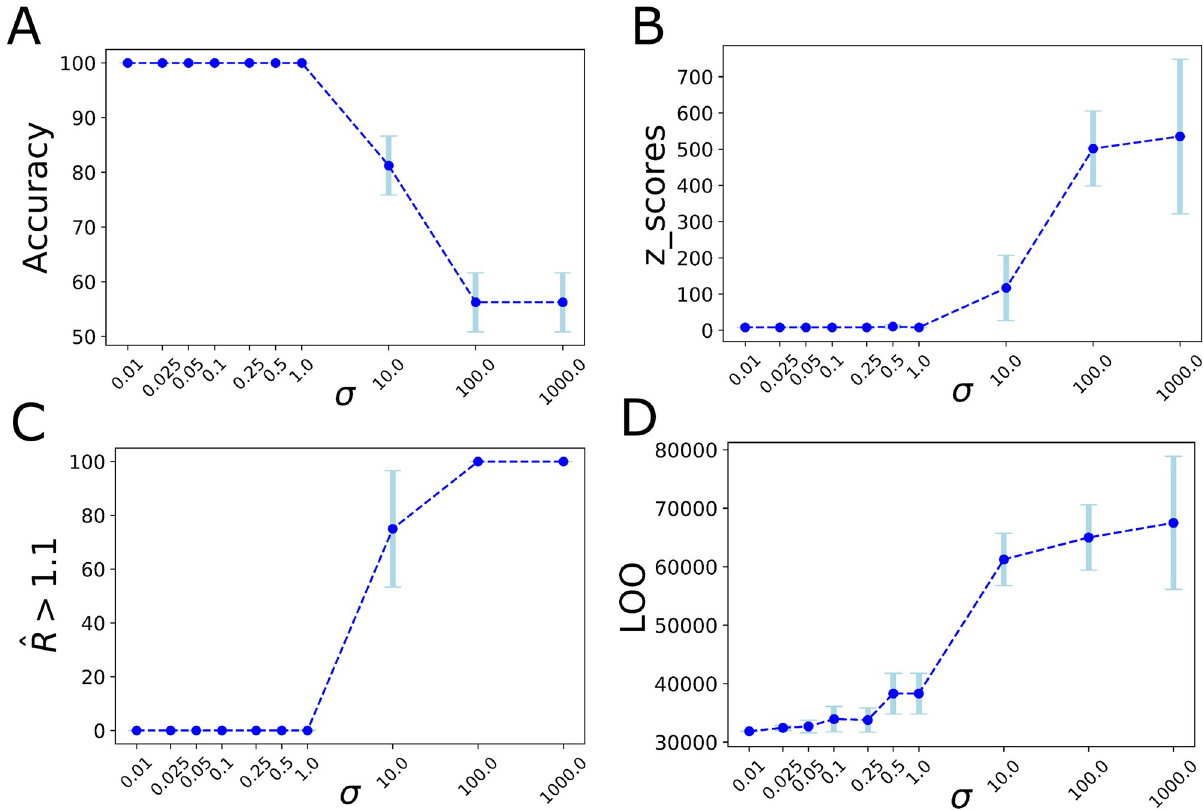
Fig 5. Effect of the prior on the model performance in the epileptogenicity estimation. Here, the prior placed on global coupling parameter K is assumed as a Gaussian distribution N ð m ¼ 1 ; s 2 Þ , where σ represents the uncertainty about the estimation varying from 0.01 to 1000. ( A ) The classification accuracy in EZ/PZ prediction. ( B ) The z-scores in excitability parameter estimation. ( C ) The potential scale reduction factor ^ R to monitor the HMC chains convergence. ( D ) LOO cross-validation as the out-of-sample model predictive accuracy. The figure plots the averages over 4 HMC chains. For σ � 1.0 all the HMC chains converged; for σ = 10.0 one out of 4 HMC chains converged; for σ � 100.0 all the chains failed to